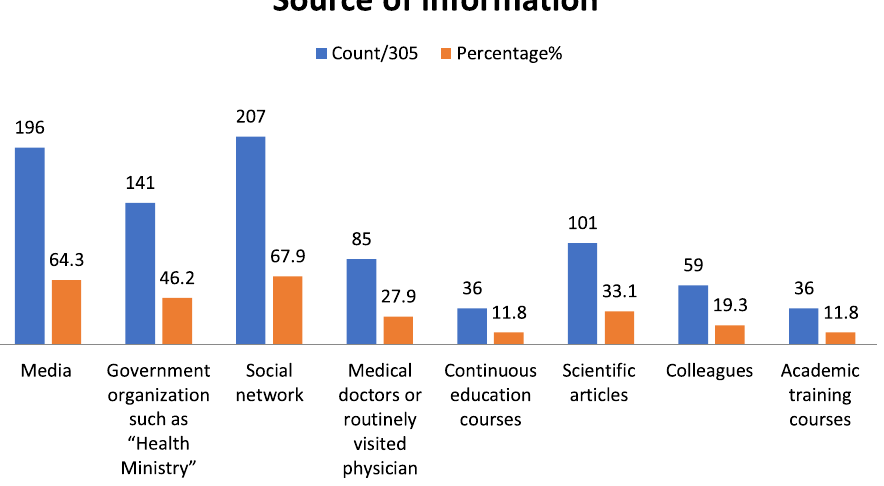
Fig. 1. Source of information used by students in this sample to learn more